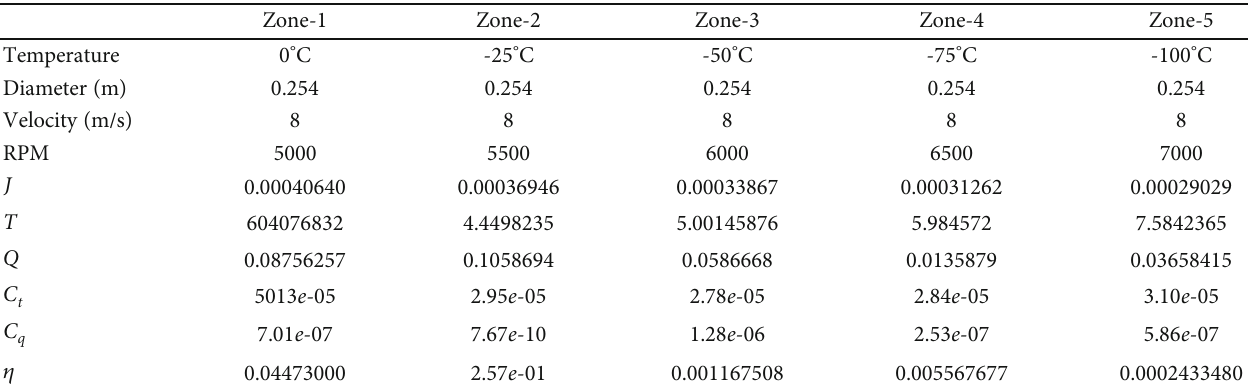
Table 5: Performance in fl uencing parameters of Design-2.